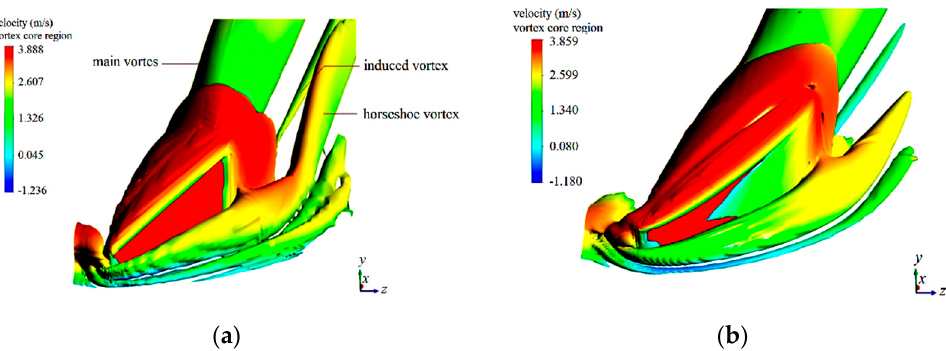
Figure 6. Core vortex region for main, horseshoe and induced vortex [107]. ( a ) TWP (trapezoidal winglet pair); ( b ) CTWP (curved trapezoidal winglet pair).